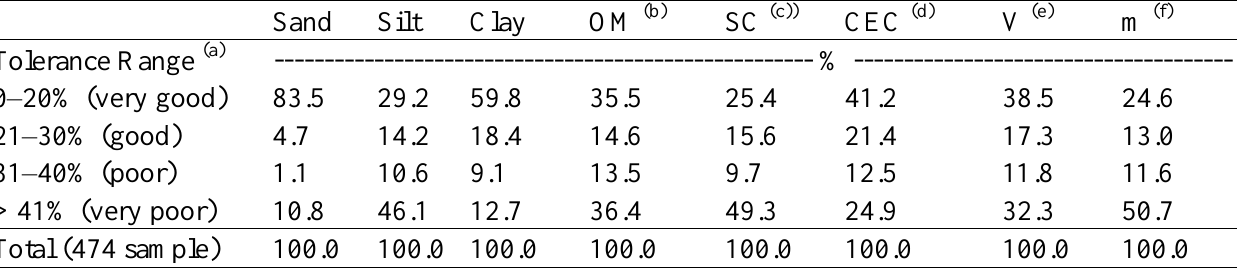
Table 4. Percentage of samples, results in the tolerance range, comparison between relative values (a) of laboratory traditional data (real value) and values obtained by the laboratory spectral